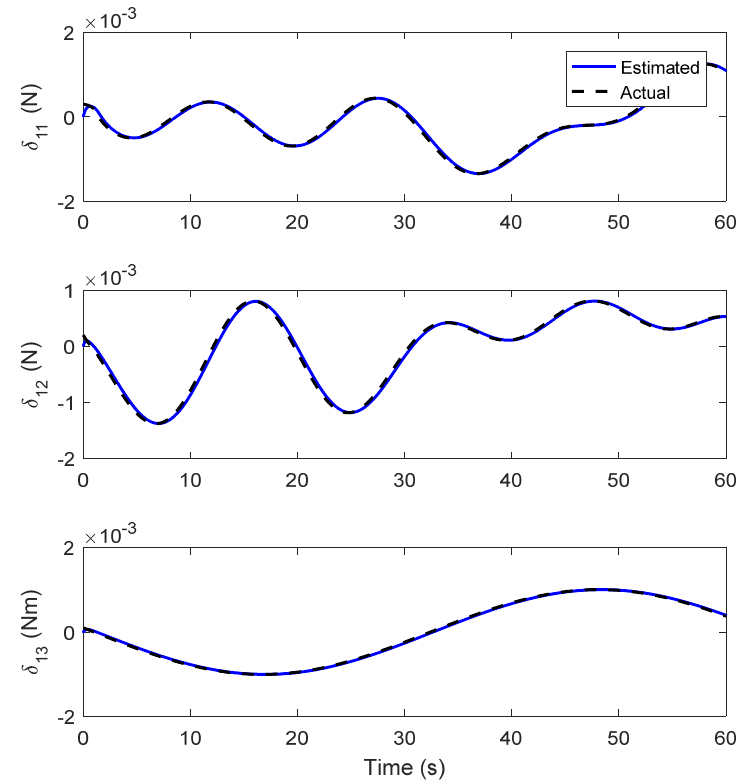
Figure 9. Mismatched lumped disturbance and estimation (Case 1).